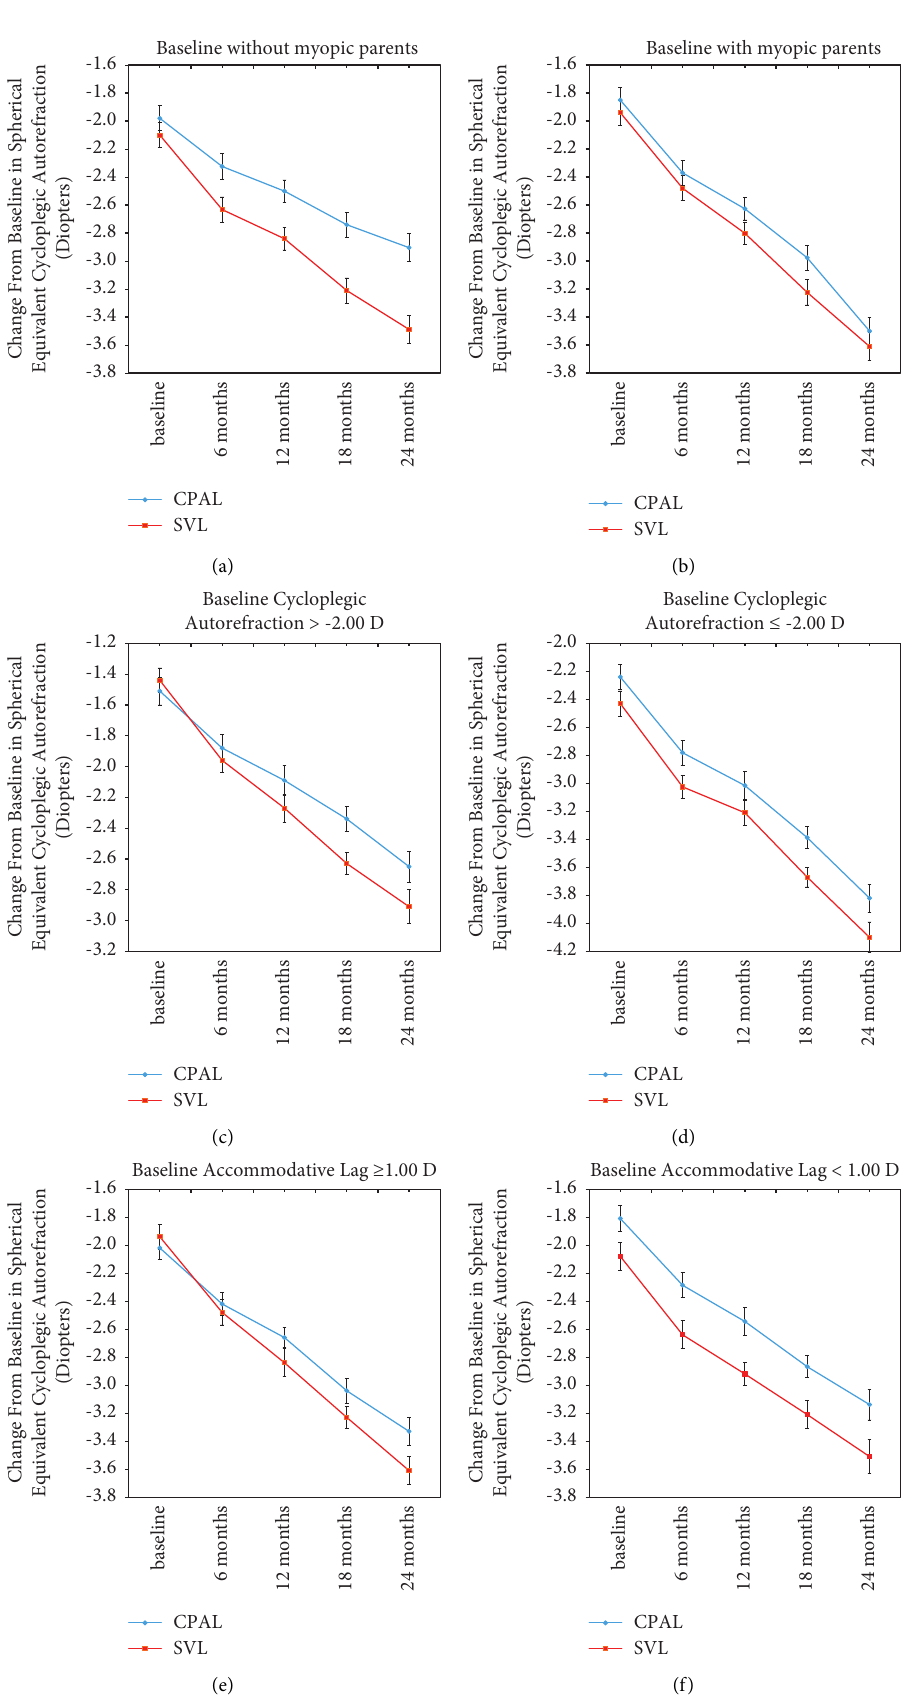
Figure 4: MeanprogressionofmyopiaintheCPALsandSVLsgroupsforthreeofthecovariates,without/withmyopicparents(a,b),baselinemyopia (c, d), and baseline near accommodative lag (e, f). Error bars: ± 1